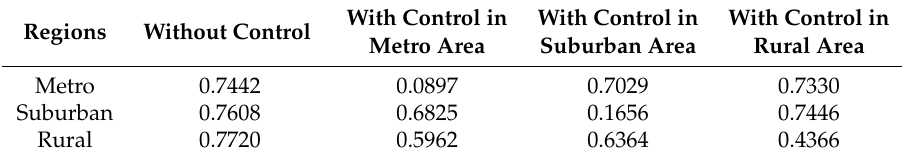
Table 10. Final population size when controlling MRSA & Behavior one ar a time when the regions are connected.